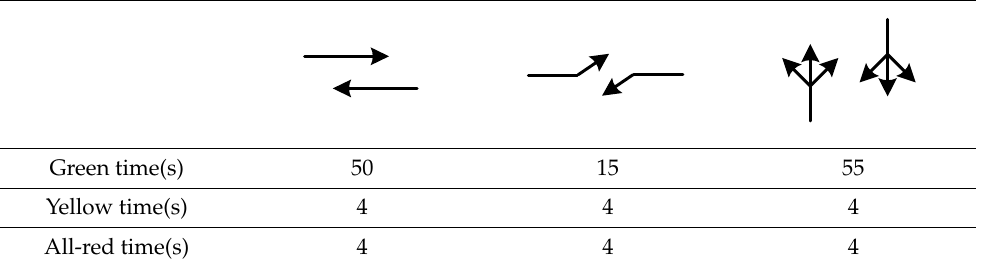
Table 4. The original intersection timing plan.